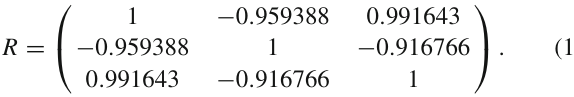
200 , 000 for which the associated numerical errors are sev- eral orders of magnitude smaller than the fit